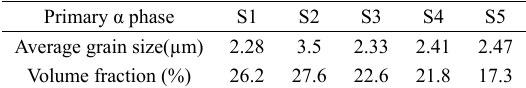
Table 1. Results of quantitative metallography